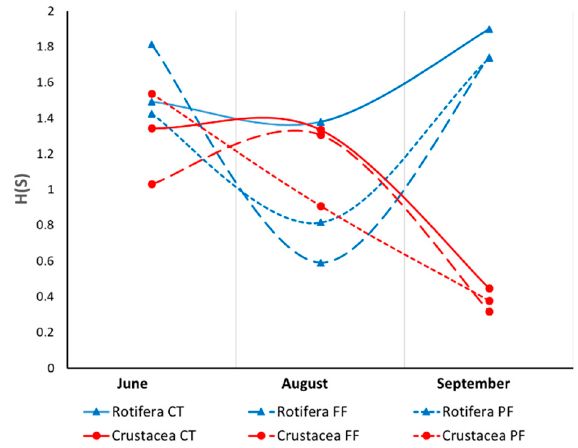
Figure 4. Changes in the Shannon diversity (H(S)) indices of the assemblages of rotifera and Crustacean communities.